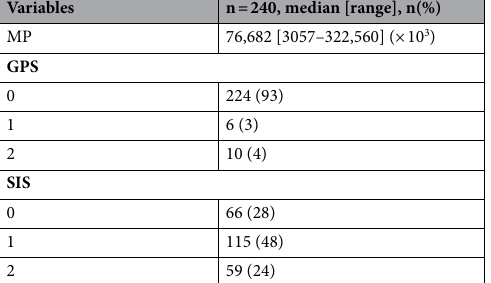
Table 1. Clinicopathological characteristics of study patients. CEA carcinoembryonic antigen, nCRT neoadjuvant chemoradiotherapy, NAC neoadjuvant chemotherapy, LAR low anterior resection, ISR